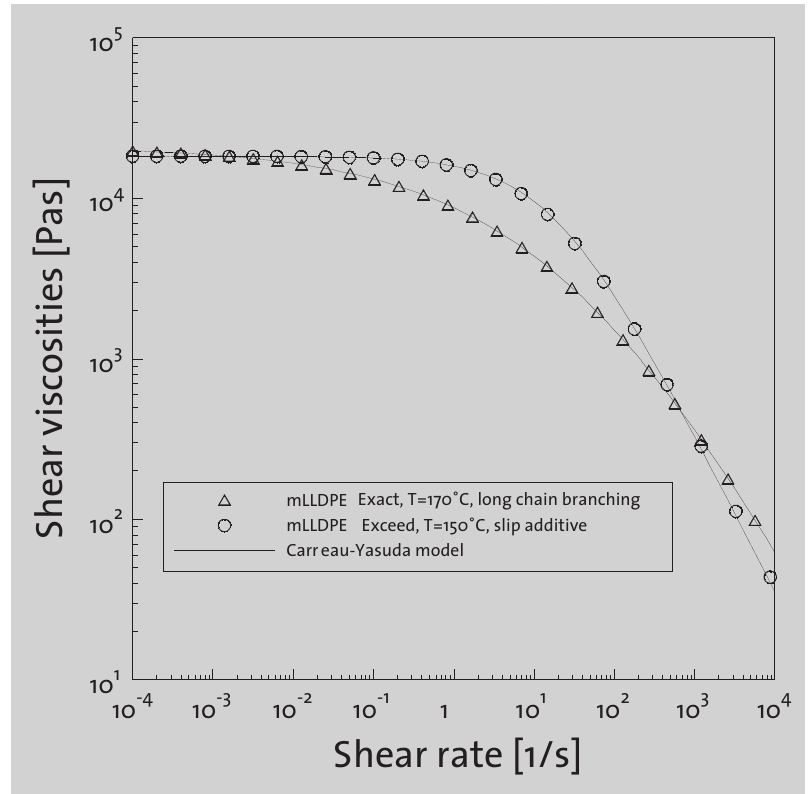
Figure 1: Measured shear viscosity data of metal- locene